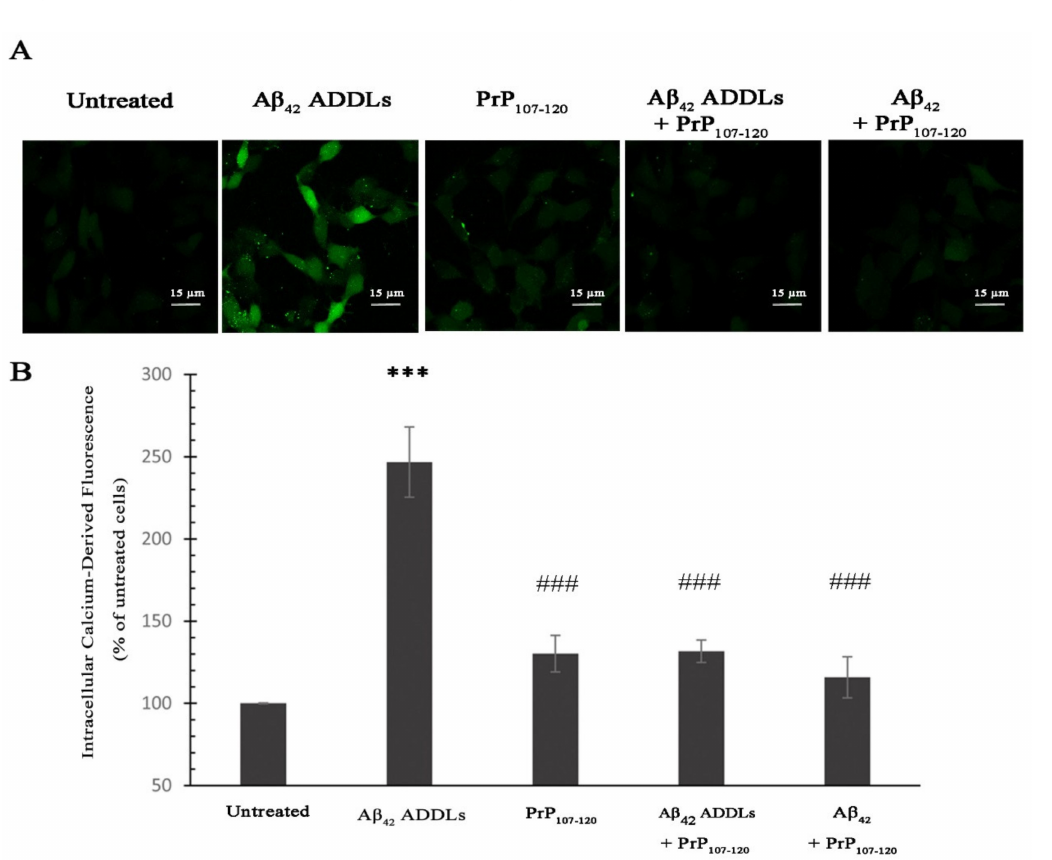
Figure 4. Analysis of intracellular Ca 2 + levels of SH-SY5Y cells treated with A β 42 oligomers